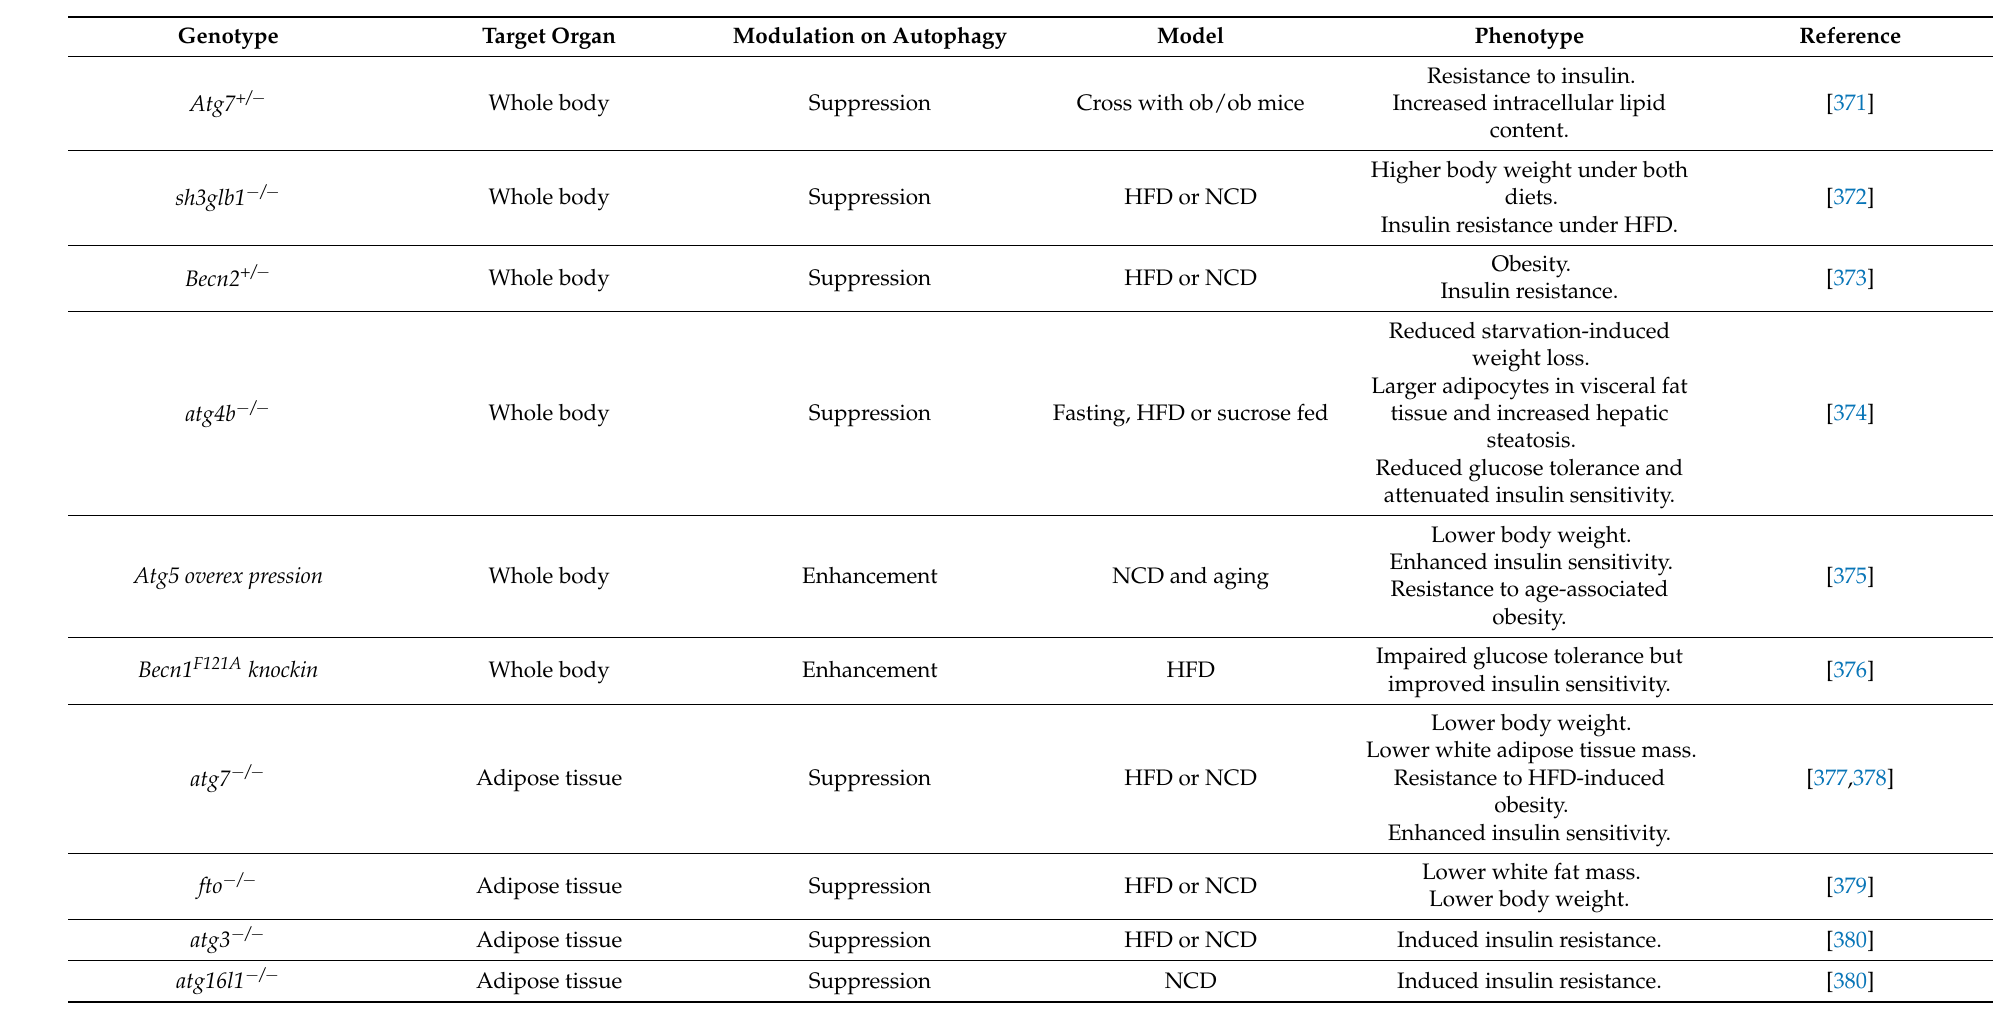
Table 2. In vivo studies of the altered autophagy effect on metabolic